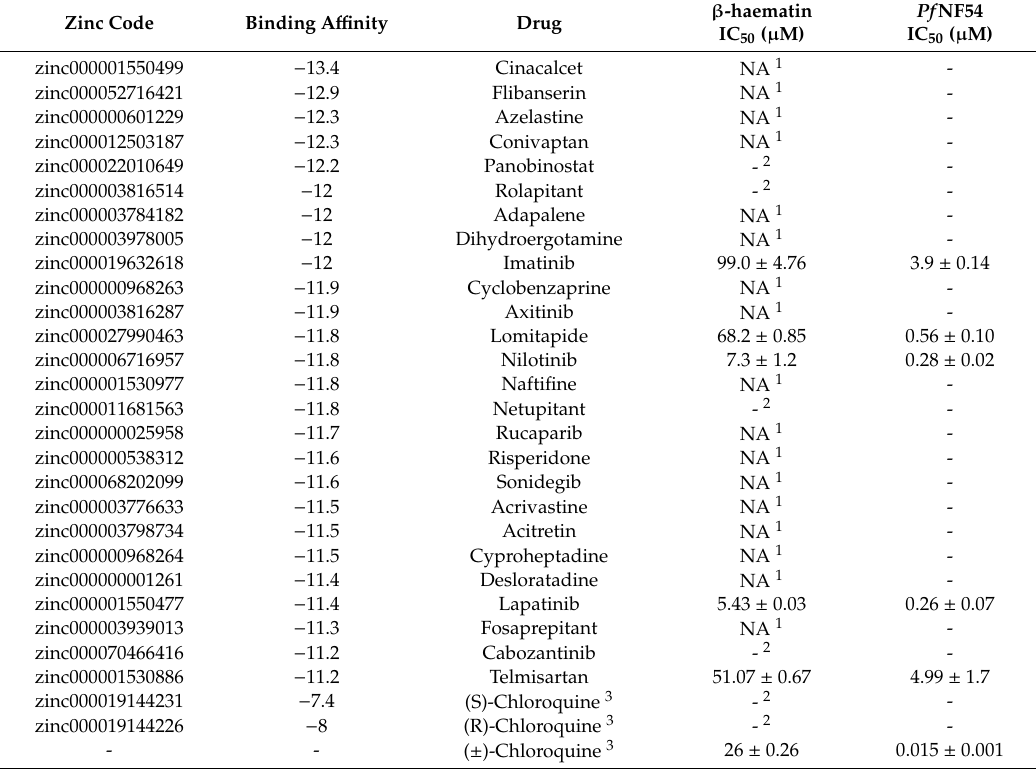
Table 2. The SBVS top-ranked FDA approved drugs and their inhibition of β -haematin formation and parasite activity in the CQ-sensitive ( Pf NF54) strain of P. falciparum